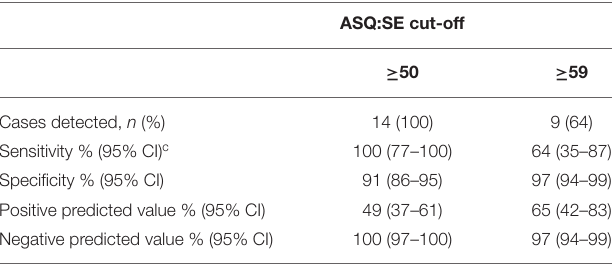
TABLE 2 | ASQ:SE a performance with different cut-off scores and using SDQ b as comparison in a population bases study of 3-year-olds. ASQ:SE